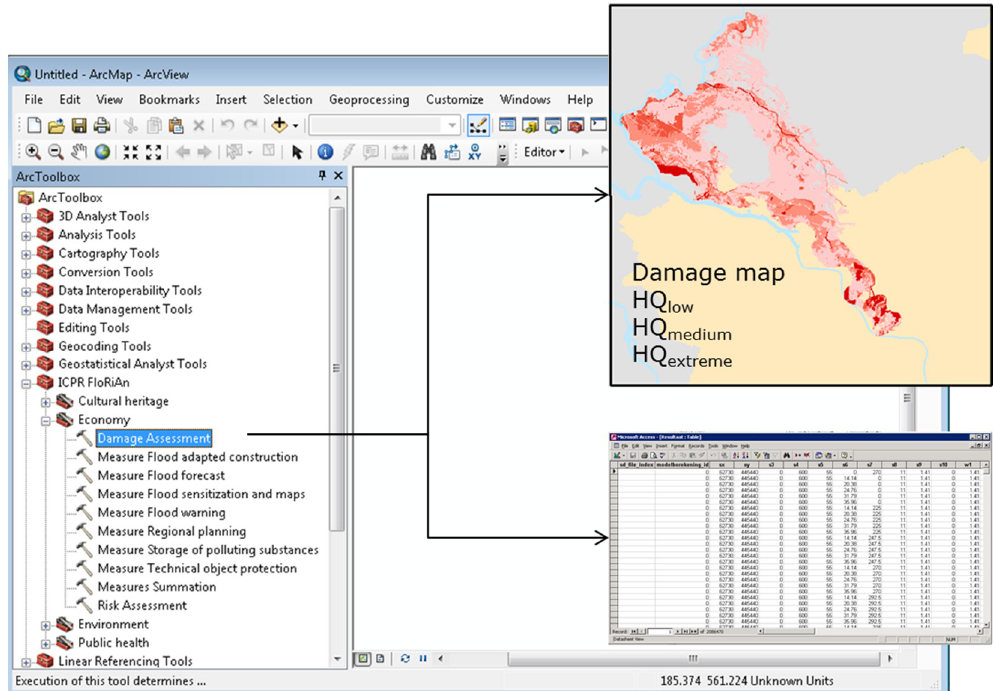
Figure 8. International Commission for the Protection of the Rhine (ICPR) FloRiAn as an ArcToolbox with the four receptors and different calculation modules as well as example of outputs (map and table).